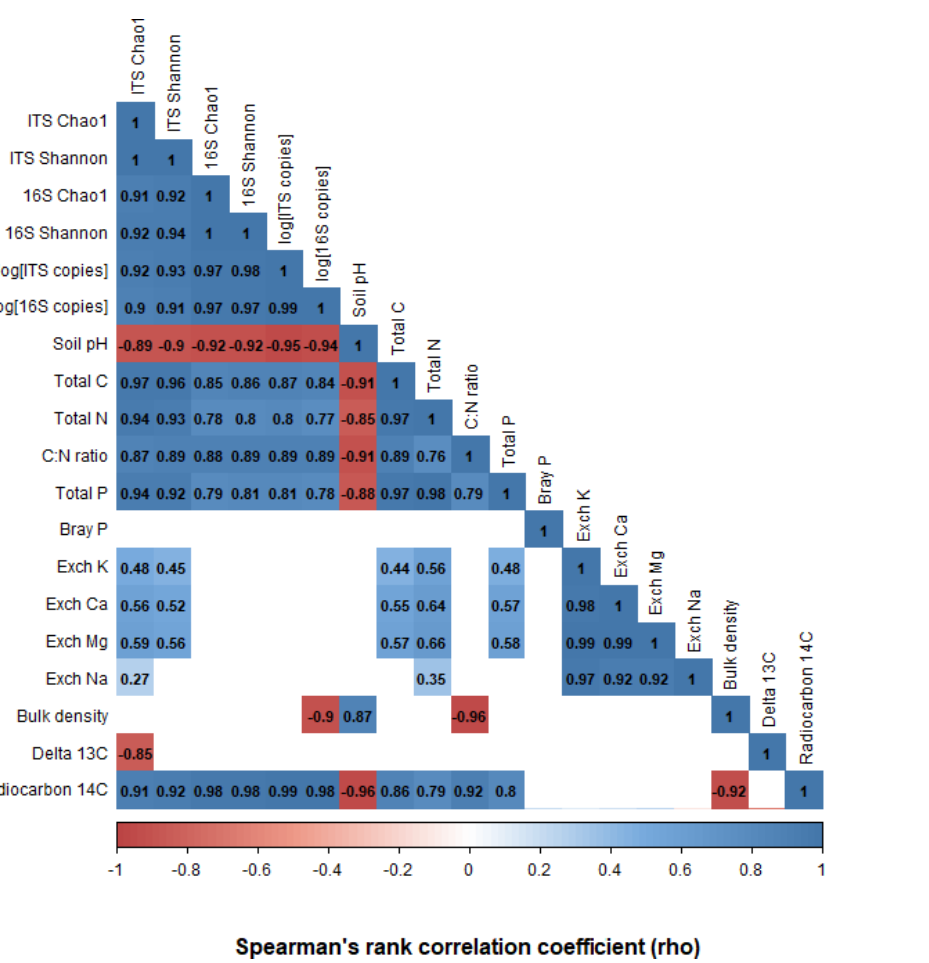
Figure 4. A pairwise Spearman’s correlation matrix showing the correlation between microbial richness, diversity, DNA abundance, and the associated soil chemical properties. Blank cells indicate non-significant ( p > 0.05) correlations.